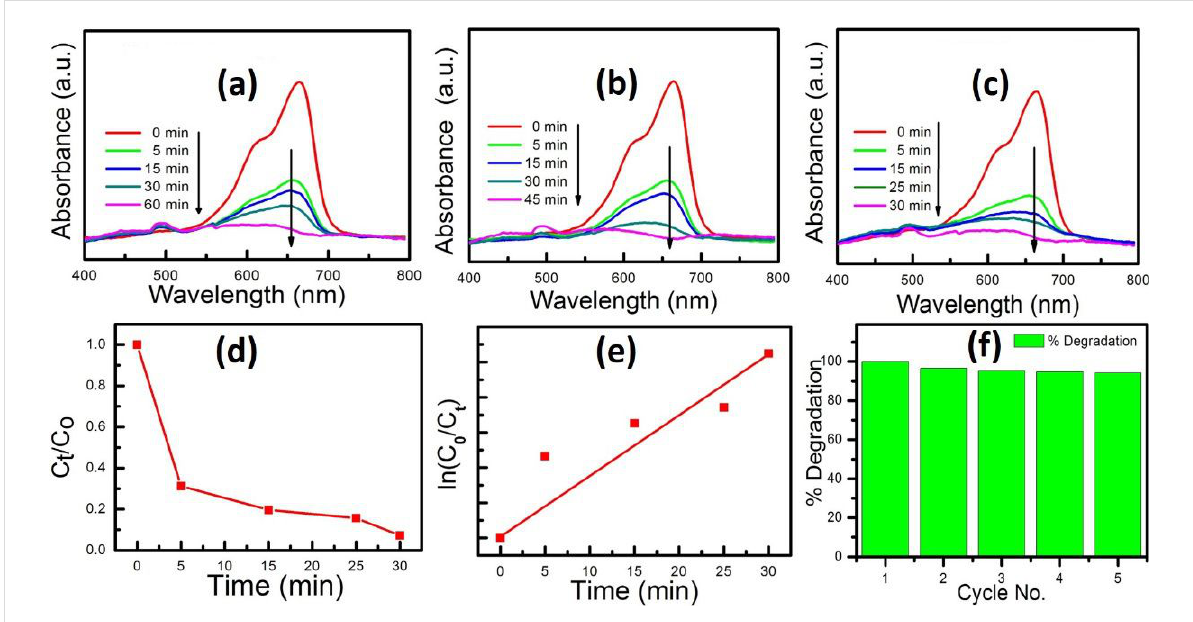
Figure 3: (a) UV–vis absorption spectra for MB degradation for different duration for 10 mg nanopetals of CuO and 0.1 mL H 2 O 2 . (b) UV–vis absorp- tion spectra for MB degradation for different duration for 10 mg nanopetals of CuO and 0.2 mL H 2 O 2 . (c) UV–vis absorption spectra for MB degrada- tion for different duration for 10 mg nanopetals of CuO and 0.5 mL H 2 O 2 . (d) The MB degradation rate in the presence of 0.5 mL H 2 O 2 and 10 mg CuO nanopetals. (e) Kinetics of degradation with 0.5 mL H 2 O 2 and 10 mg CuO nanopetals. (f) The % degradation vs cycle number for MB degrada- tion with 0.5 mL H 2 O 2 and 10 mg CuO